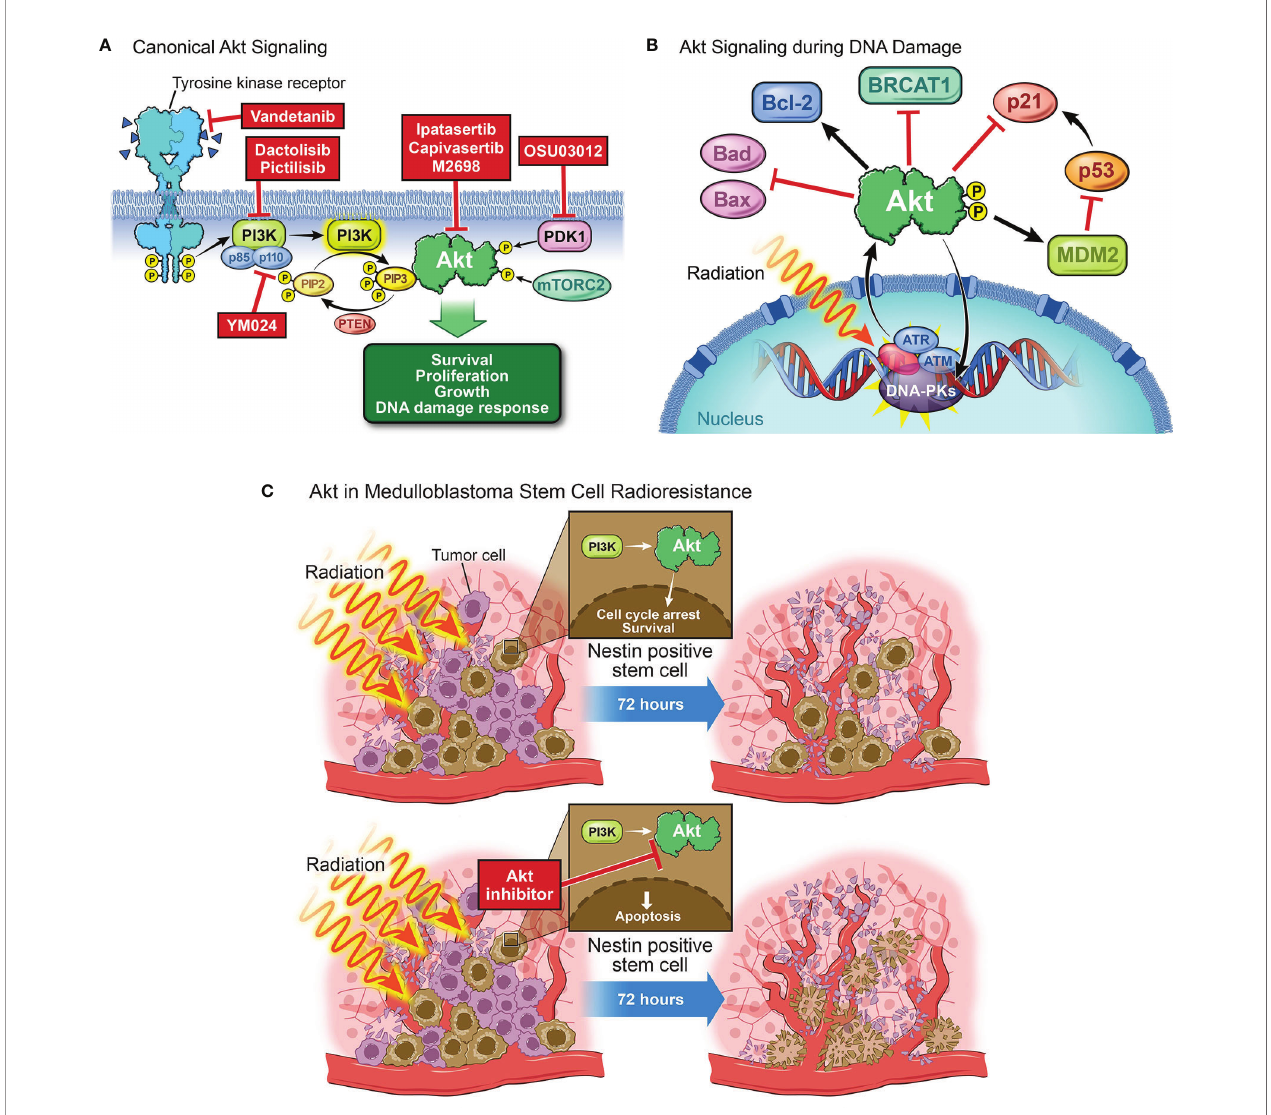
FIGURE 3 | The role of AKT in DNA damage. (A) Canonical AKT signaling begins with the activation of a receptor tyrosine kinase (e.g., VEGFR, EGFR, or IGFR). Receptor activation, by binding of a ligand, dimerization, and autophosphorylation, causes binding and activation of p85 and p110, the respective regulatory and catalytic subunits of PI3K. Activated PI3K will go on to catalyze the conversion of PIP2 to PIP3, a process which can be reversed by the tumor suppressor PTEN. If PIP3 is formed, it will recruit AKT to the membrane at which point AKT will be phosphorylated by PDK1 and mTORC2. This dual phosphorylation fully activates AKT, allowing it to affect several downstream processes such as cell survival, proliferation, growth, and the DNA damage response. (B) Following exposure to radiation, repair proteins (e.g. ATM, ATR, DNA-PKs) are recruited to the damaged site to facilitate repair. The activation and recruitment of these proteins correlates with an increase in phosphorylated AKT. p-AKT then inhibits apoptosis through Bad and Bax inhibition and Bcl-2 activation. p-AKT will also inhibit the downstream target of p53, p21, to inhibit cell cycle arrest. A feedback loop exists in that AKT can also phosphorylate and activate these proteins to aid in DNA repair. AKT facilitates NHEJ by phosphorylating DNA-PKs and inhibits HR by promoting cytoplasmic localization of BRCA1 and Rad51. (C) Irradiation decreases the population of tumor cells at the perivascular niche with the exception of stem cells which are largely radioresistant. Nestin-positive stem cells in the perivascular niche treated with radiation activate the PI3K/AKT pathway to undergo cell cycle arrest and re-enter the cycle 72 hours later, driving MB survival and recurrence. AKT inhibition prior to irradiation abrogates perivascular stem cell radiation resistance, leading to apoptosis of these